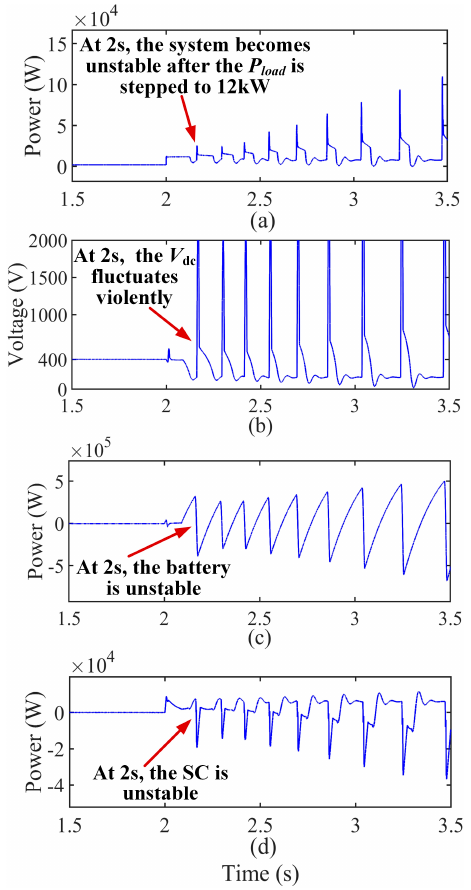
Figure 15. Simulation results when control parameters of Group D are used. ( a ) CPL power, ( b ) DC bus voltage, ( c ) battery power and ( d ) SC power.